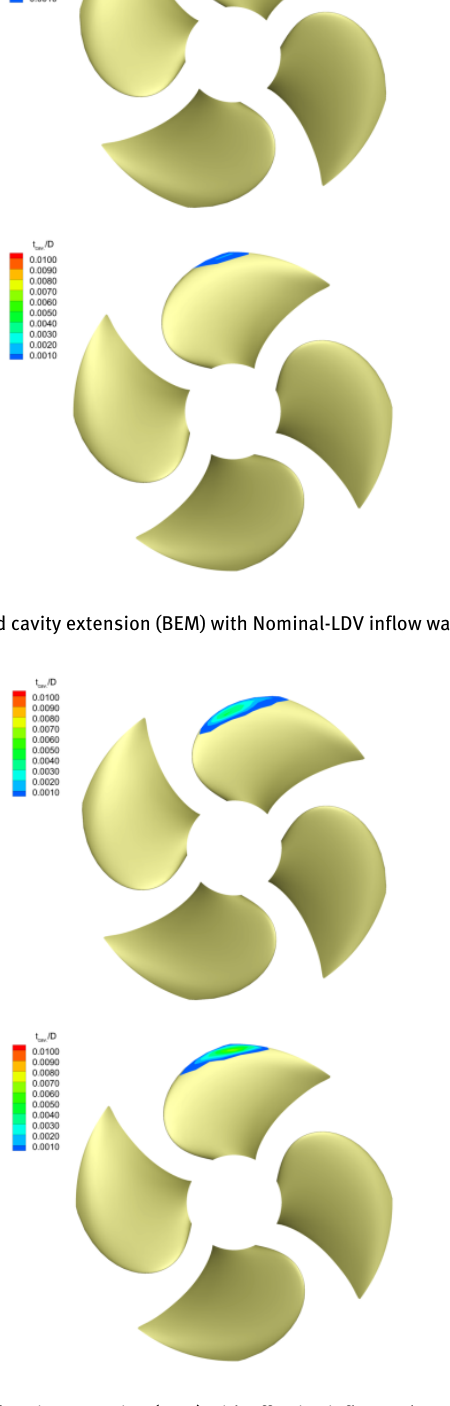
Figure 11: Predicted cavity extension (BEM) with Effective inflow